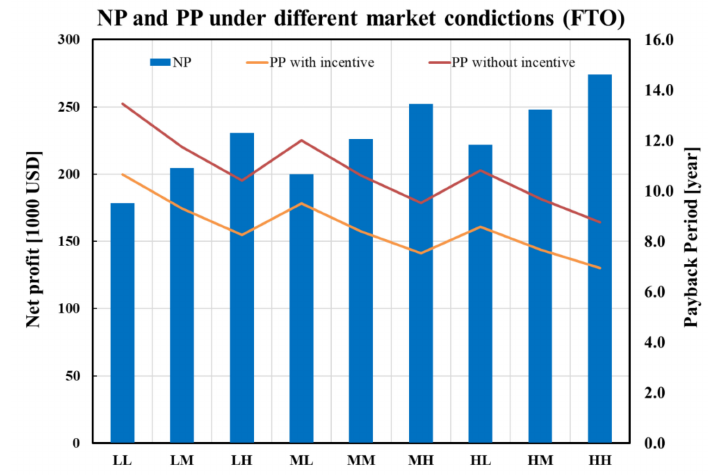
Figure 15. Net profit and payback period under the FTO model with different electricity market